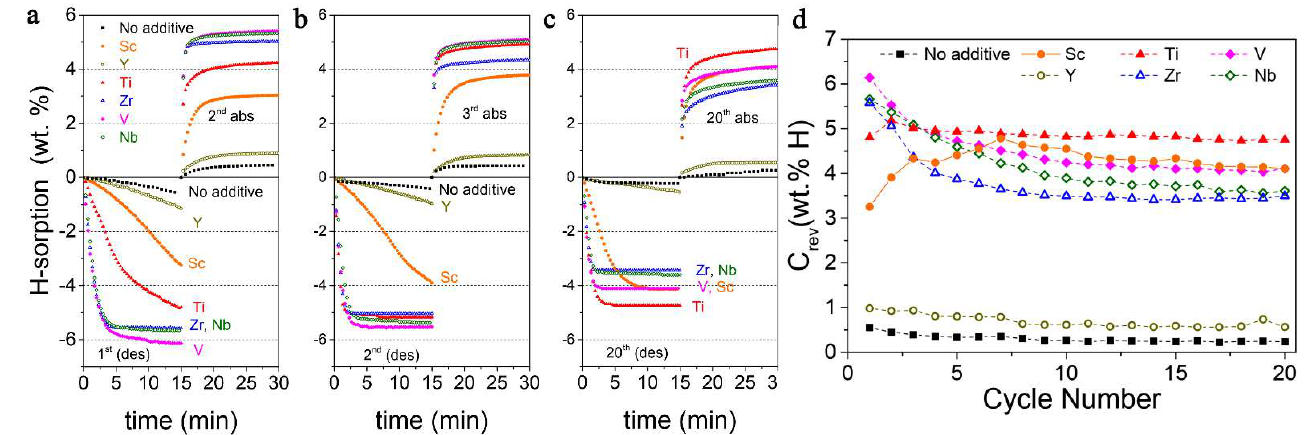
Figure 21. Hydrogen sorption curves recorded during the 2 nd ( a ), 3 rd ( b ) and 20 th ( c ) absorption cycle for as-synthesized nanocomposites. Evolution of reversible hydrogen storing capacity with number of cycles ( d ). Reprinted/adapted with permission from Ref. [169]. 2019, Royal Society of Chemistry.